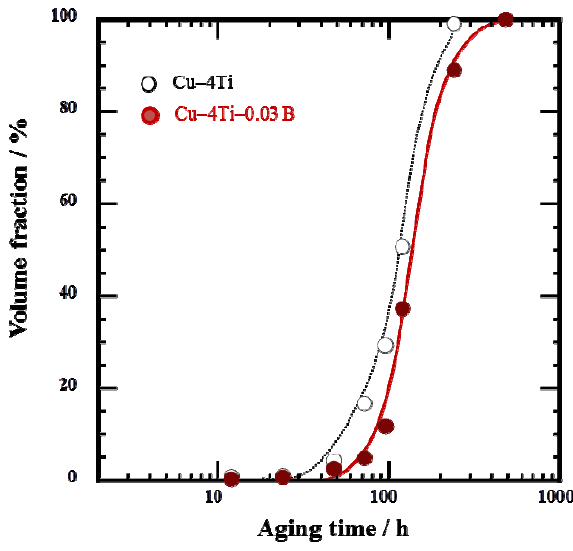
Figure 3. Volume fraction of cellular discontinuous precipitates in Cu–4Ti–0.03B and Cu–4Ti alloys that were aged at 450